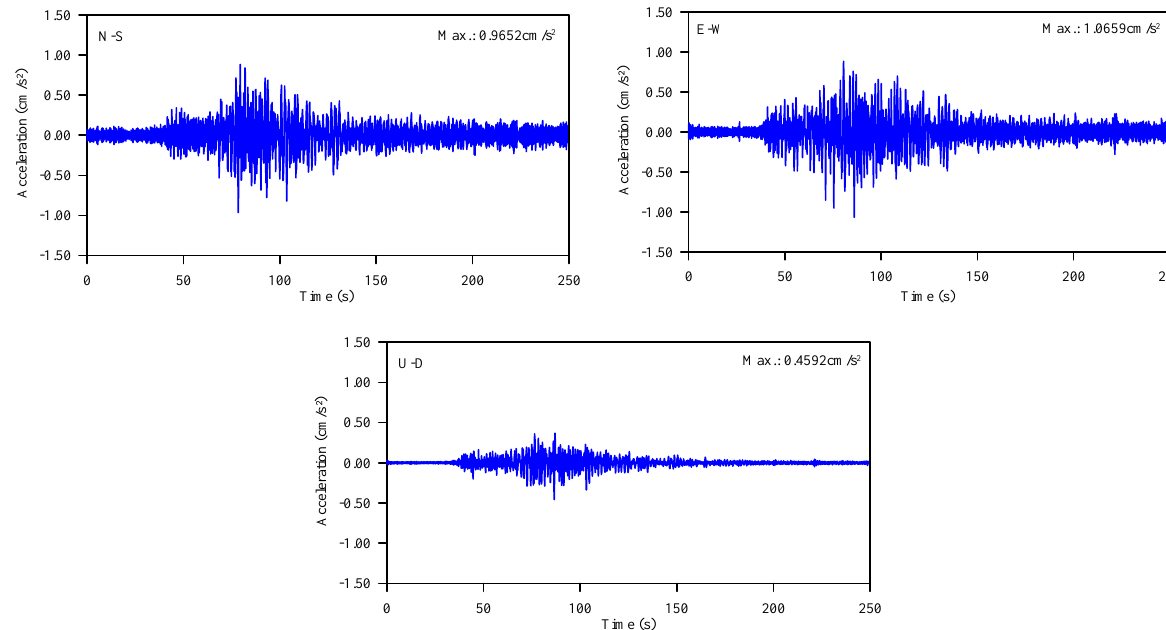
Fig. 4. Acceleration records of Bala (Ankara) Earthquake on 20 December 2007.